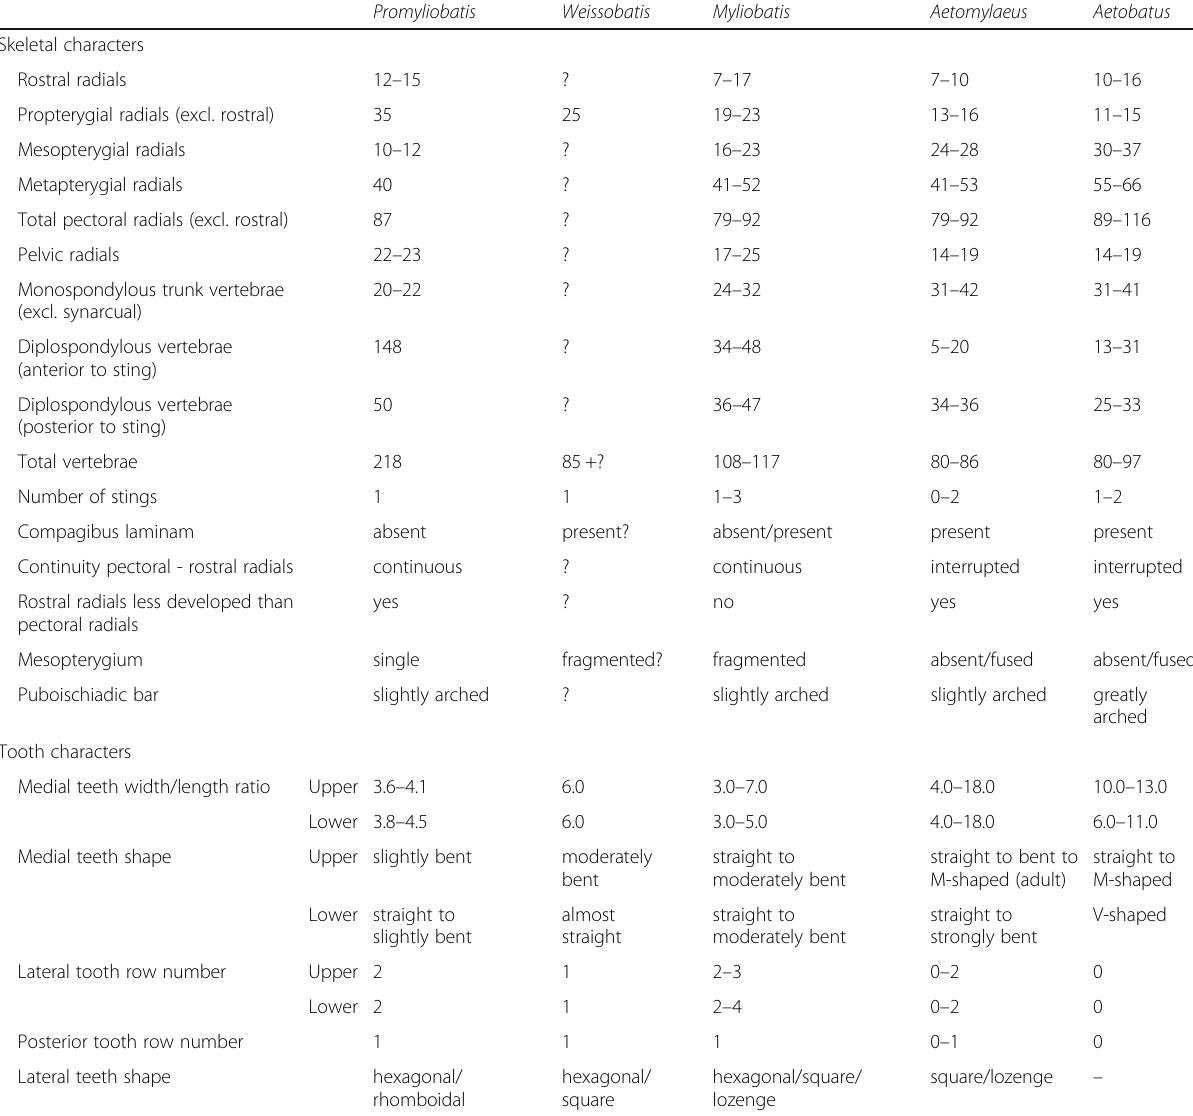
Table 2 Selected skeletal and dental characters in selected pelagic durophagous stingray